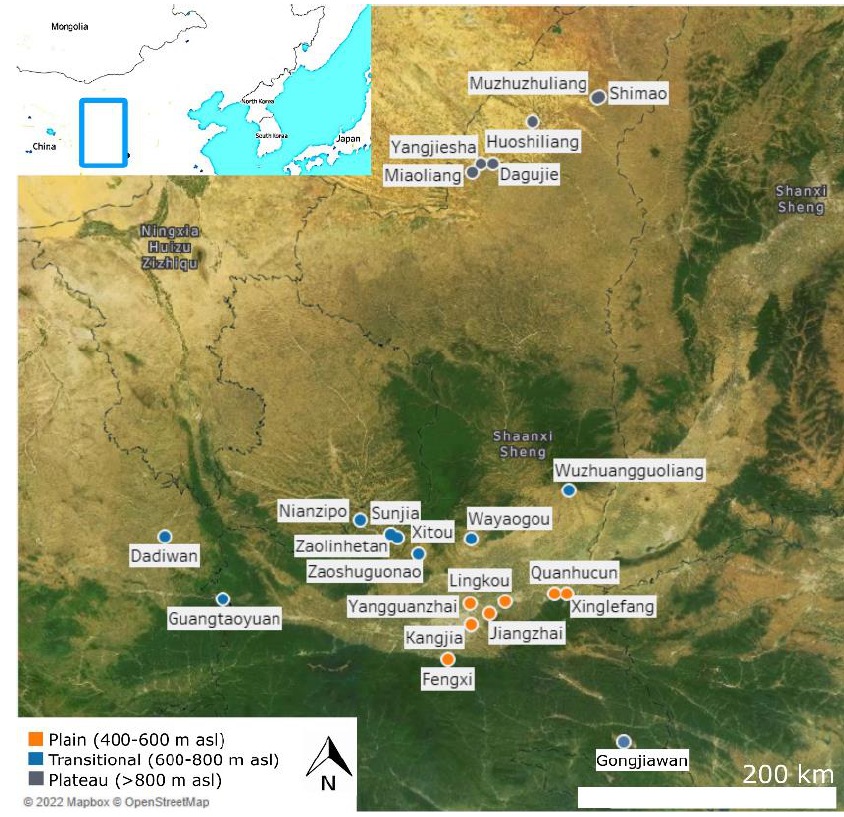
Figure 1. Map showing sites referenced in this paper. Table 1. Chronology of Northern China and coordinates of the sites included in this study. Chro- nologies for Chinese archaeological cultures are determined on the basis of a large number of cali- brated radiocarbon dates obtained from archaeological sites, which are published in [35].